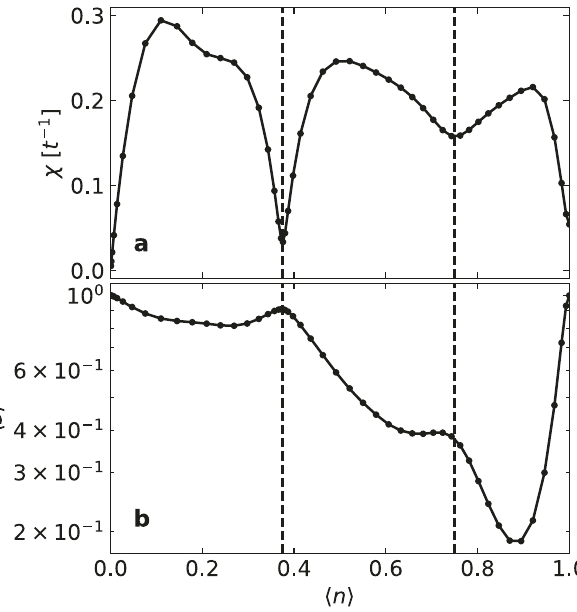
Fig. 3 Fermion sign — charge compressibility correspondence. a Charge compressibility χ = ∂ 〈 n 〉 / ∂ μ and b fermion sign 〈 s 〉 plotted against electron density 〈 n 〉 at magnetic fi eld strength Φ / Φ 0 = 12/64, inverse temperature β = 6/ t and Hubbard interaction U / t = 4. This system is particle-hole symmetric, so we only plot the density range 〈 n 〉 ∈ [0, 1]. Dashed lines indicate electron densities at which χ reaches local minina and 〈 s 〉 reaches local maxima. Error bars, corresponding to ±1 standard error of the mean, estimated by jackknife resampling, are smaller than the size of data